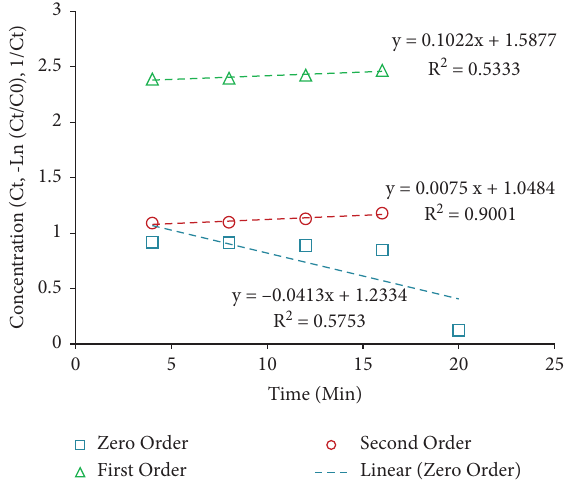
Figure 8: Diagram of nonlinear processing kinetics studied. Table 4: Constant coefcients of ATN removal reaction kinetics. Kinetic Kinetic